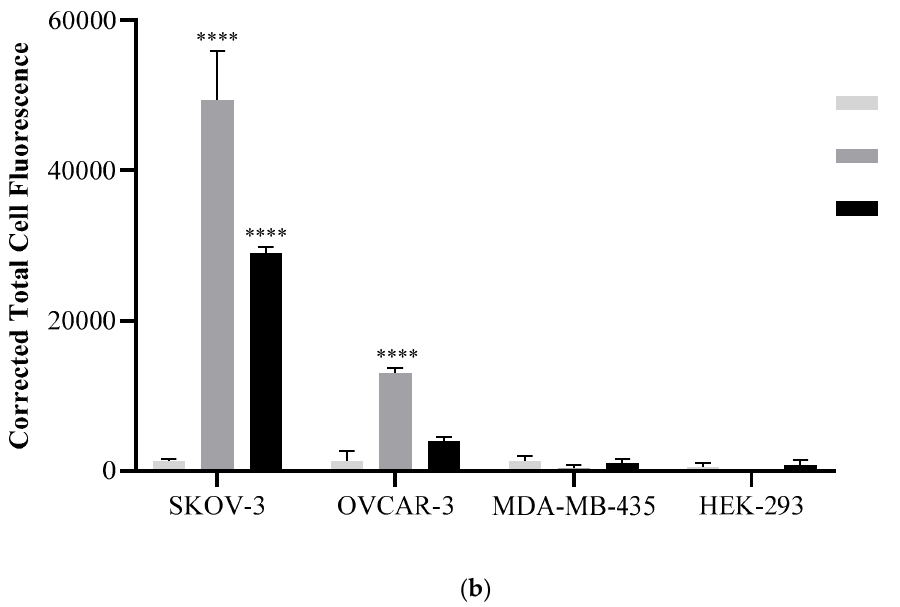
Figure 2. ( a ) Fluorescent microscopy of peptide binding to SKOV-3, OVCAR-3, MDA-MB-435, and HEK293 cells. Cells were incubated with 10 μ M biotinylated J18, J24, or PBS for 1 h at 37 °C. Bound peptides were probed by a mouse monoclonal anti-biotin antibody and detected using an epifluorescent Nikon T1-SM inverted microscope (Nikon, Melville, NY, USA). ( b ) The corrected total cell fluorescence was determined using ImageJ software. Results showed that peptide J18 displayed higher fluorescence compared to PBS (vehicle) for SKOV-3 and OVCAR-3 cells. Peptide J24 demonstrated higher fluorescence to SKOV-3 cells. A p -value of < 0.05 was considered significant. **** p < 0.0001. Red (cy3-peptides).